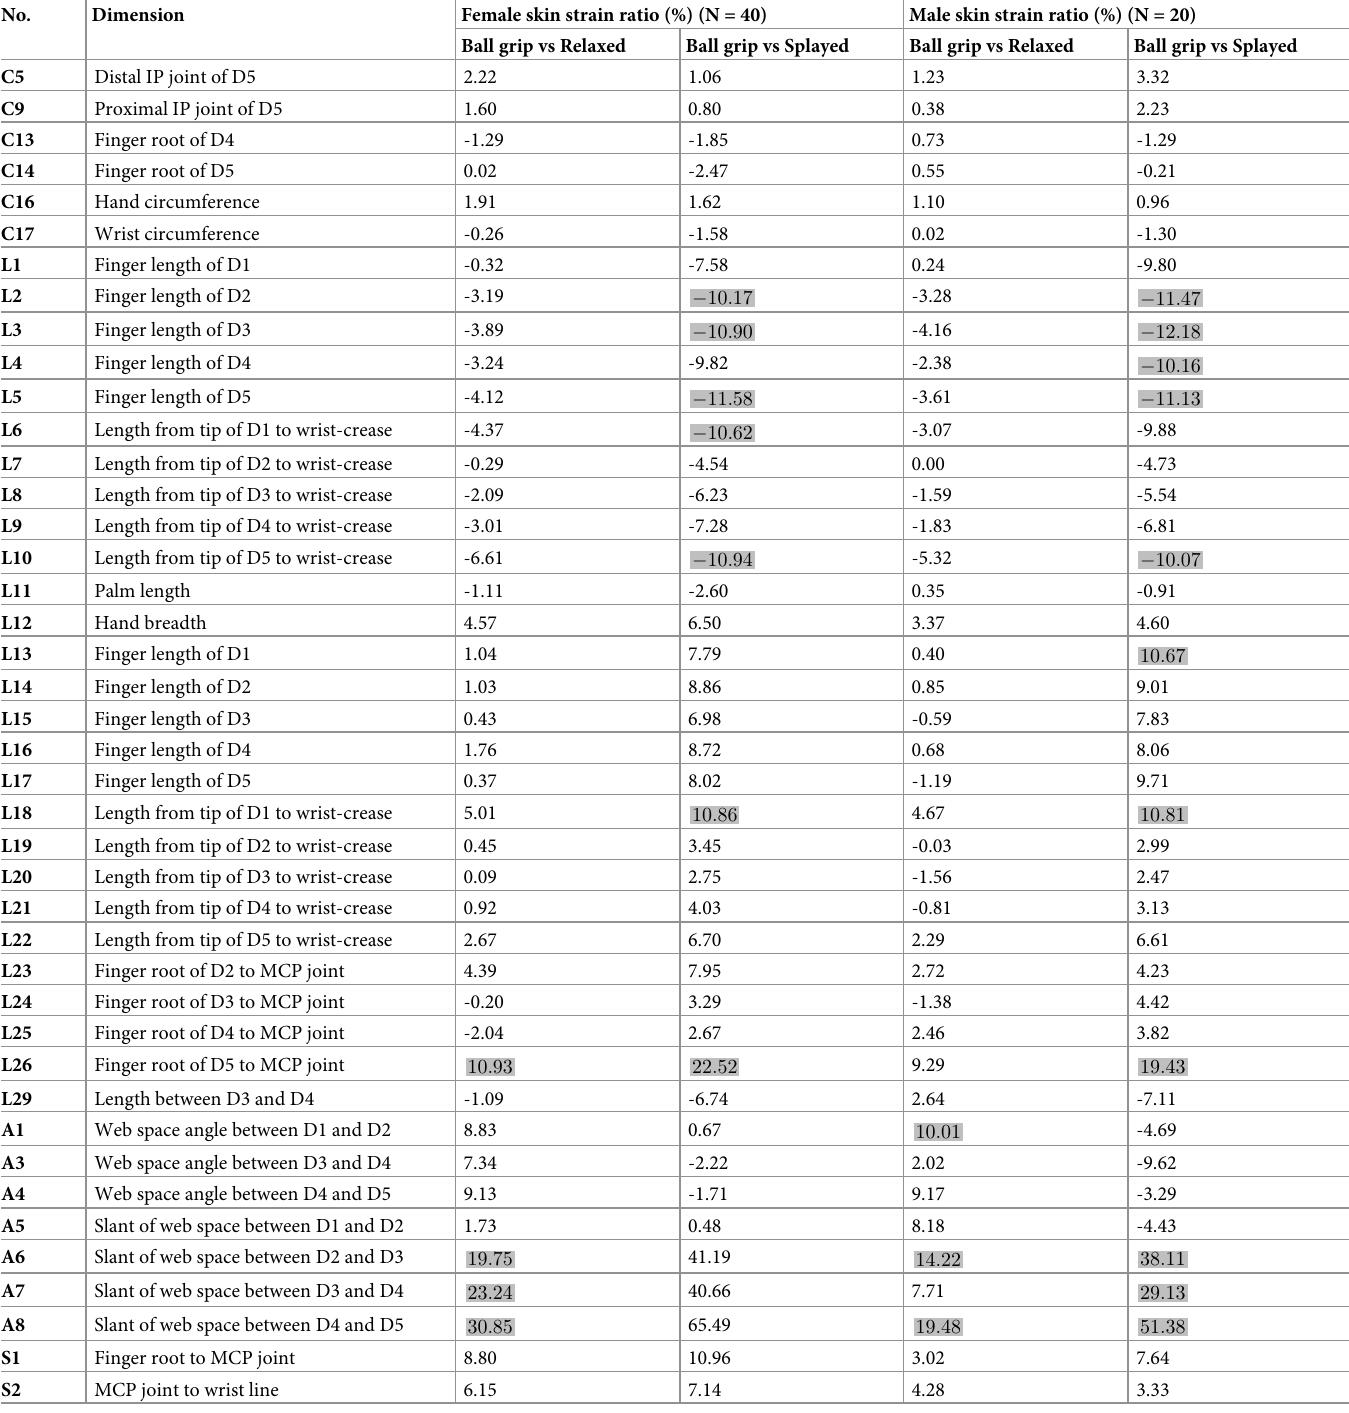
a Skin strain ratio of � ± 10% are shaded